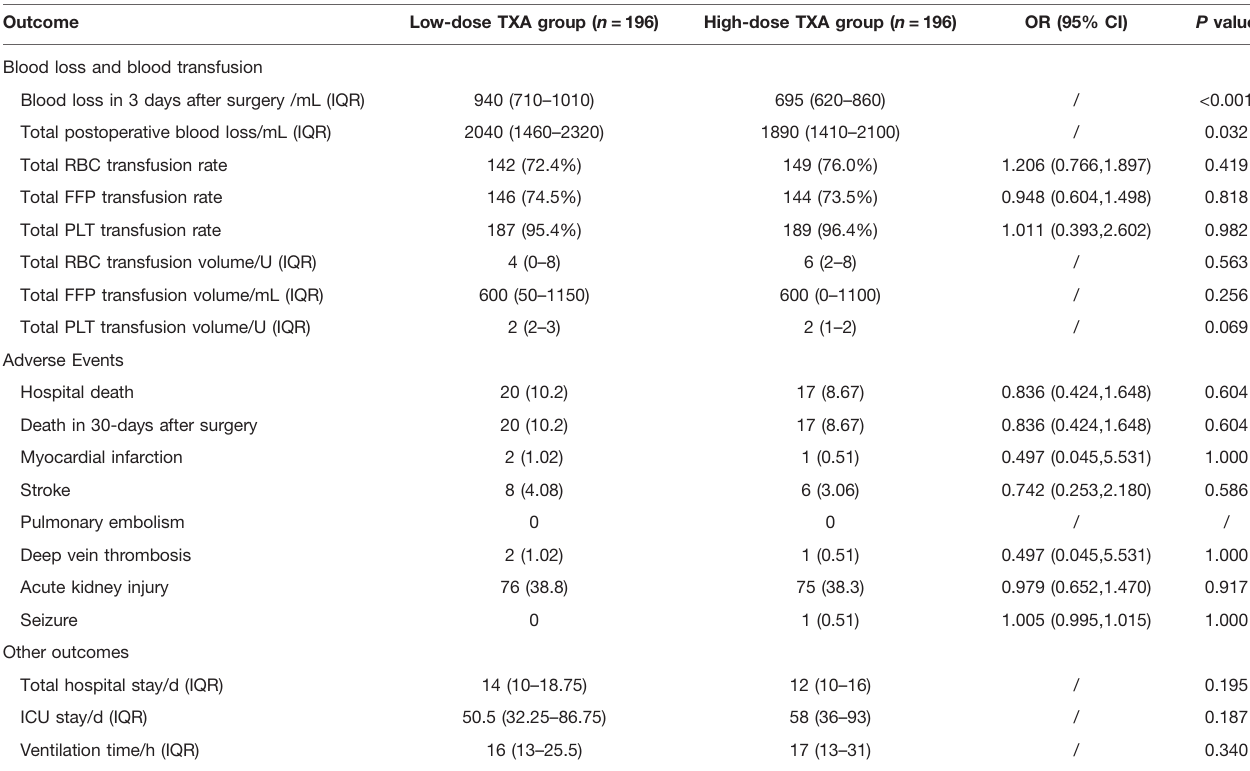
TABLE 2 | Outcomes for low-dose and high-dose TXA groups after matching.